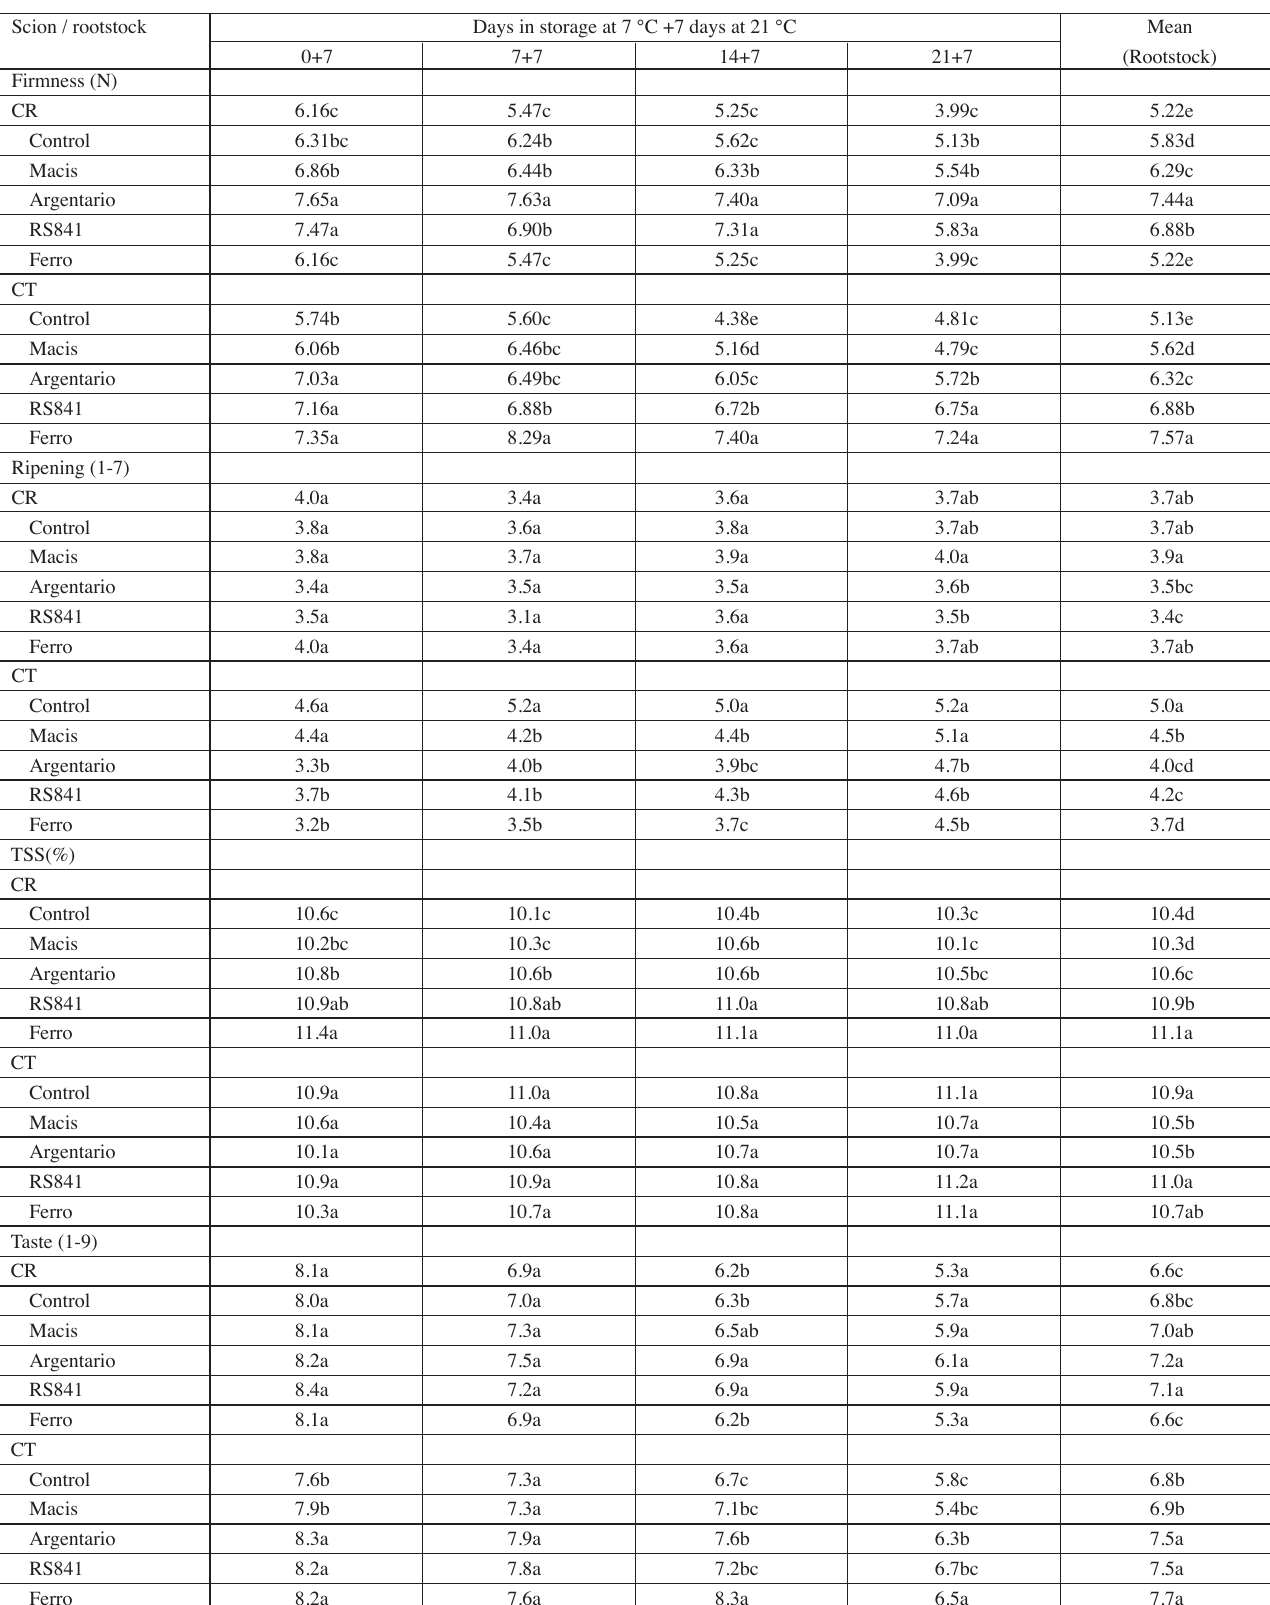
Tab. 2: Effects of rootstocks on some quality attributes of ‘Crisby’ (CR) and ‘Crimson Tide’ (CT) watermelon fruits after shelf life period for 7 days at 21 °C following storage at 7°C Scion /